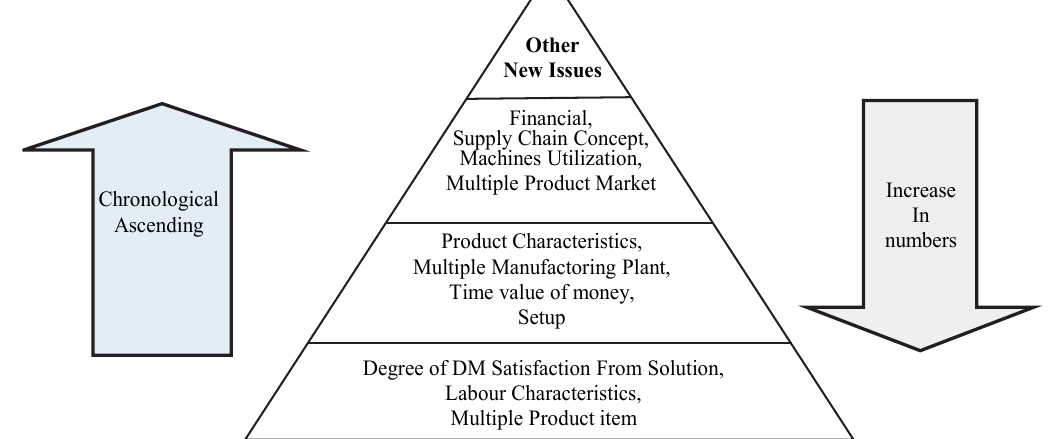
Fig. 3. Important issues according to the number of studies and the the publication date of